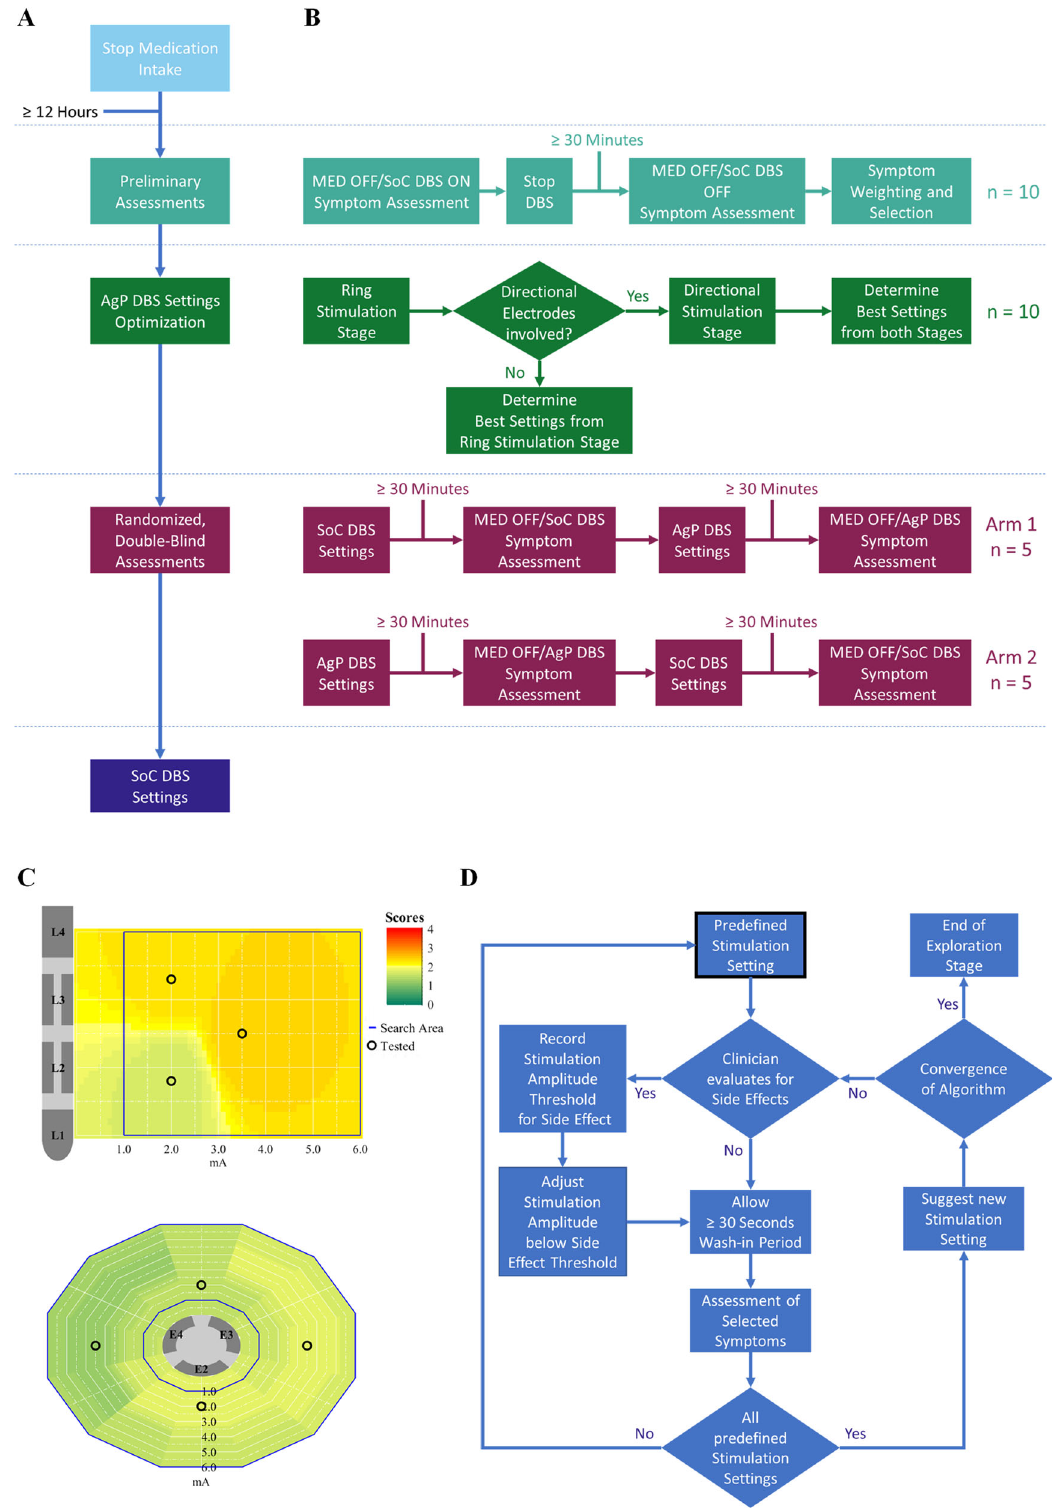
Fig. 5 Overview of main phases and speci fi c task of the study. Block diagrams of A the main phases of the study visit and B the speci fi c tasks performed at each of them. C Examples of score maps for the prede fi ned exploration points at the two AgP exploration stages. The algorithm starts with the same standard prede fi ned stimulation settings, which were three and four for the ring and directional mode exploration stages, respectively (circles on panels). D Block diagram for both AgP exploration stages. Ring mode stimulation constitutes the fi rst AgP exploration stage. If the ring mode stimulation setting leading to the best clinical effect involves the activation of directional electrodes, the algorithm continues with the second exploration stage, which involves directional mode stimulation settings. The black contoured block indicates the start of the corresponding exploration